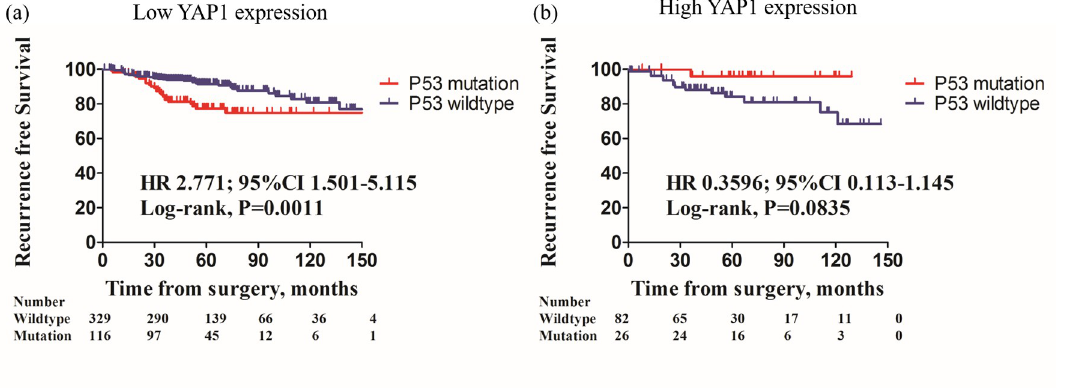
Fig 4. Kaplan-Meier survival curves of RFS in relation to presence of p53 mutation with low/high nuclear YAP1 expression. In patients with low nuclear YAP1 expression, p53 mutation pattern exhibited inferior RFS than p53 wild-type pattern (a, HR 2.771, 95% CIs 1.501–5.115, P = 0.0011, log-rank test). However, in patients with high nuclear YAP1 expression, p53 mutation pattern was not significantly different OS than p53 wild-type pattern (b, HR 0.3596, 95% CIs 0.113–1.145; P = 0.0835, log-rank